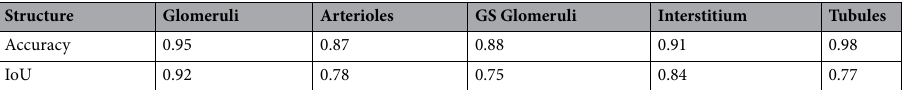
Table 2. Deep learning segmentation results. GS, globally sclerosed; IoU, intersection over union.